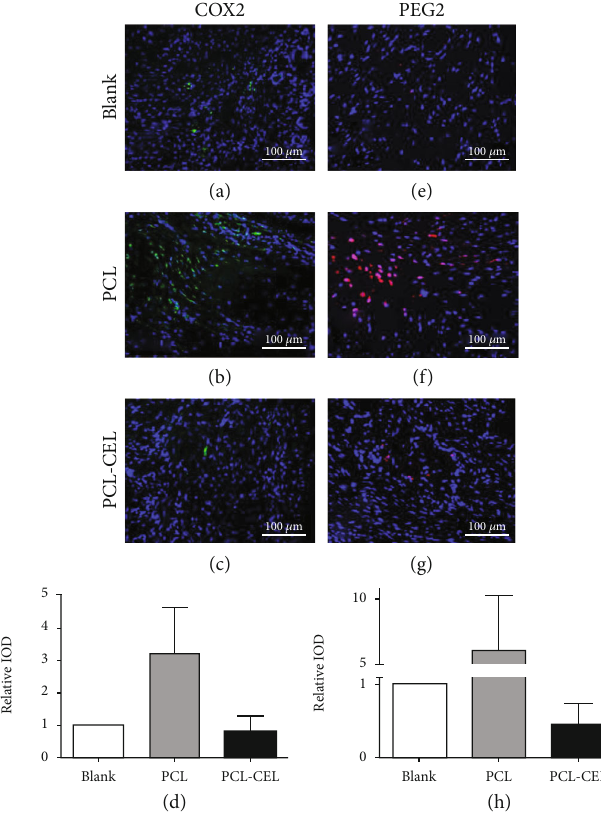
Figure 4: Immuno fl uorescence of tissue around epidural fi brosis. (a – d) Expression of COX-2; (e – h) expression of PGE